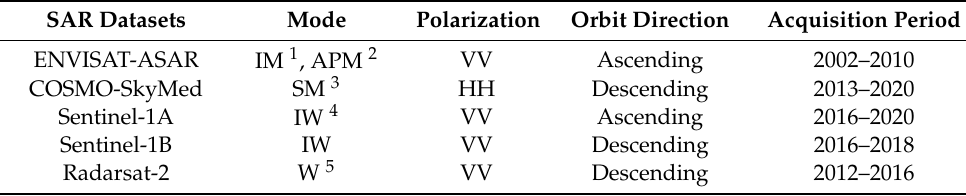
Table 2. List of principle SAR datasets used in this study.